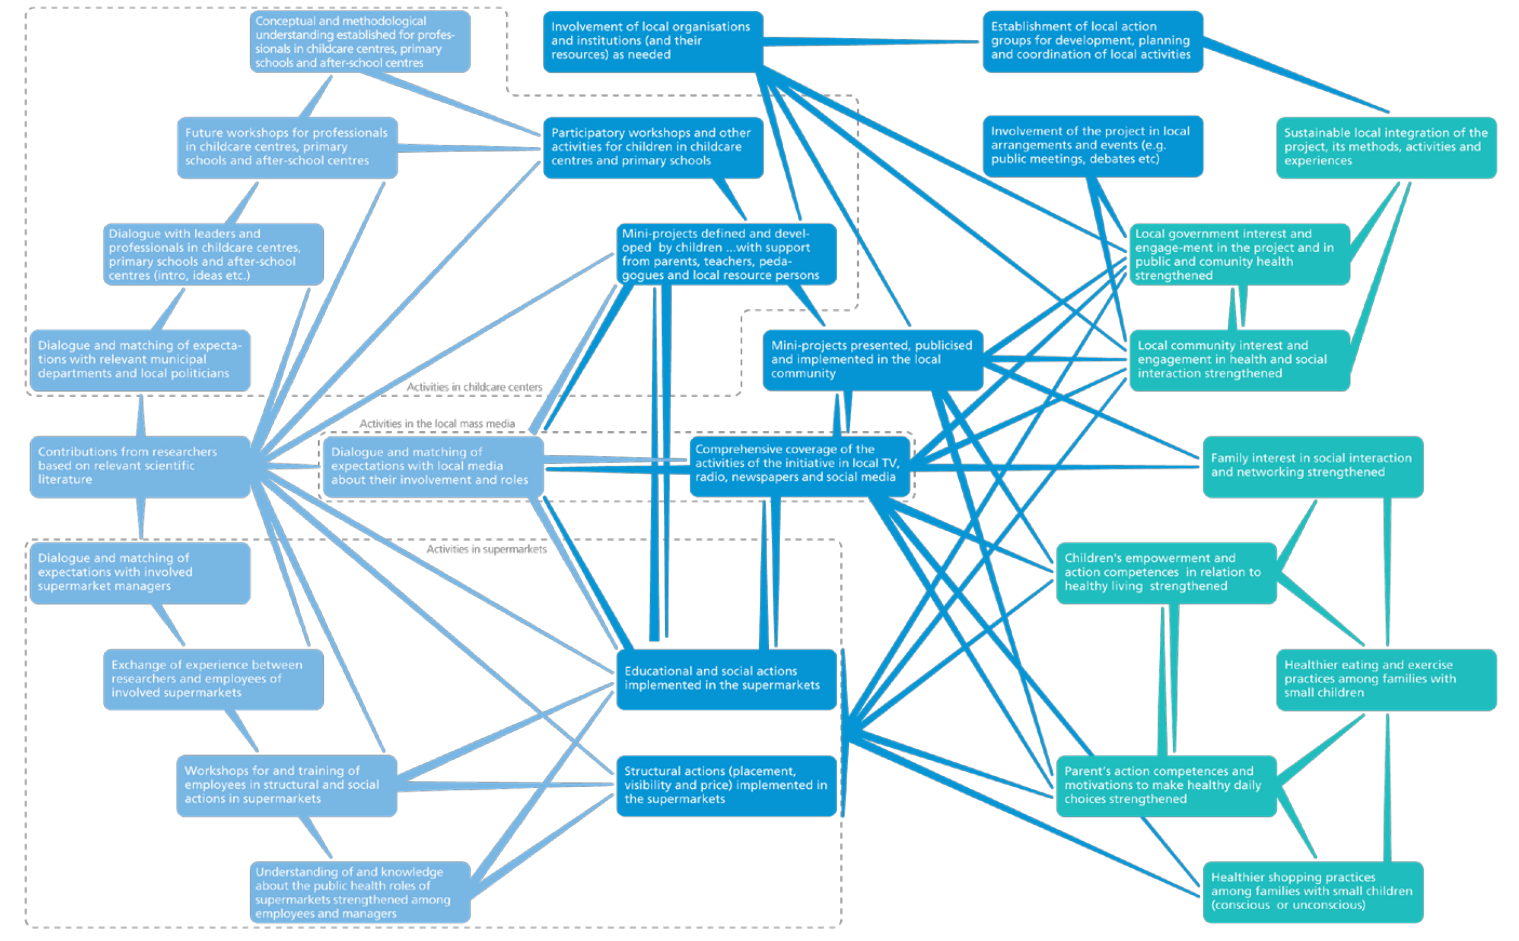
Figure 2. Programme theory for Project SoL .